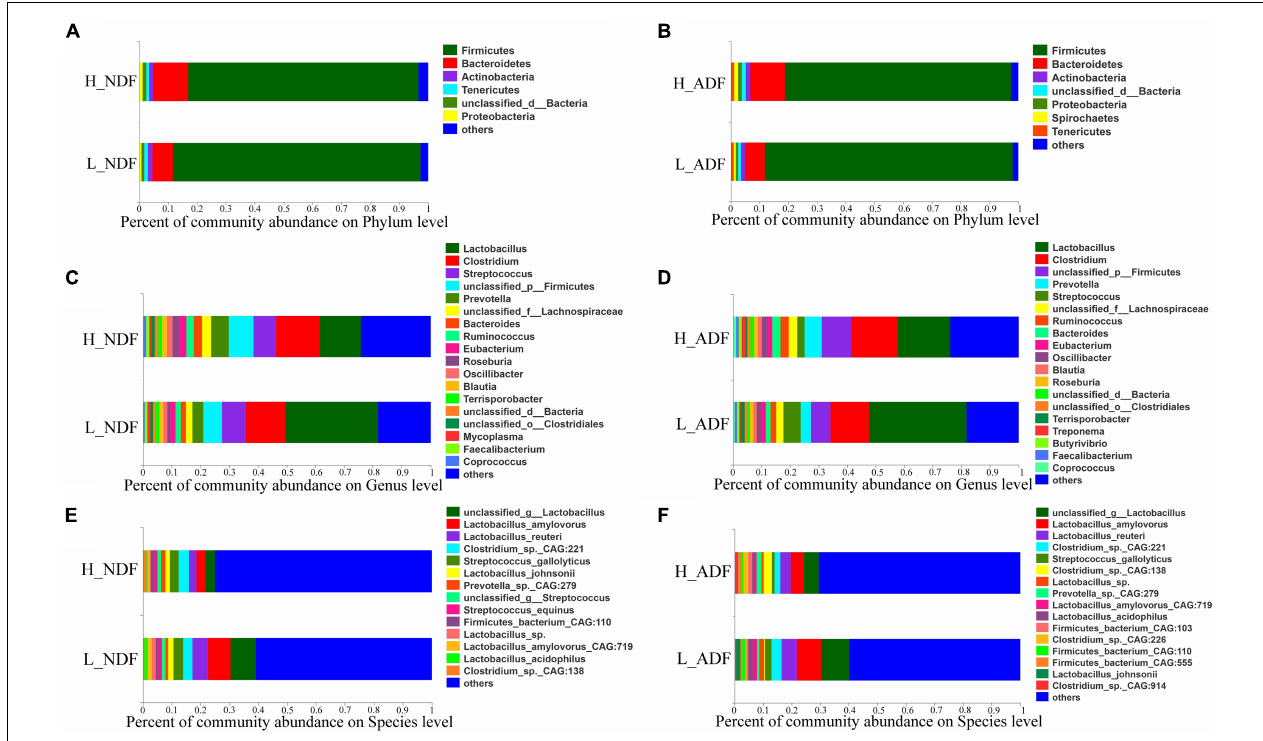
FIGURE 1 | The gut microbiota composition of Suhuai pigs at phylum, genera, and species level. Relative abundance of dominant microbiota at the phylum (A,B) , genus (C,D) , and species (E,F) levels in NDF and ADF groups were shown by stacked bar graphs. Those less than 1% of bacteria were merged into others.